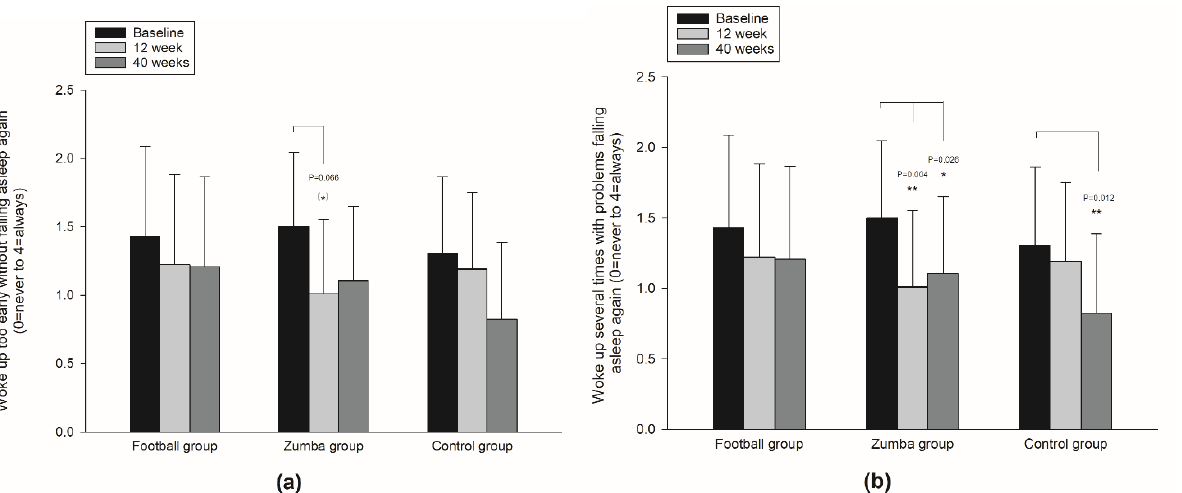
Figure 5. Within-group changes over 12 and 40 weeks in frequency of waking up too early without falling asleep again ( a ); and frequency of waking up several times with problems falling asleep again ( b ). Significant within-group change denotes; ** ( p < 0.01), * ( p < 0.05), ( * ) ( p < 0.1) tendency for